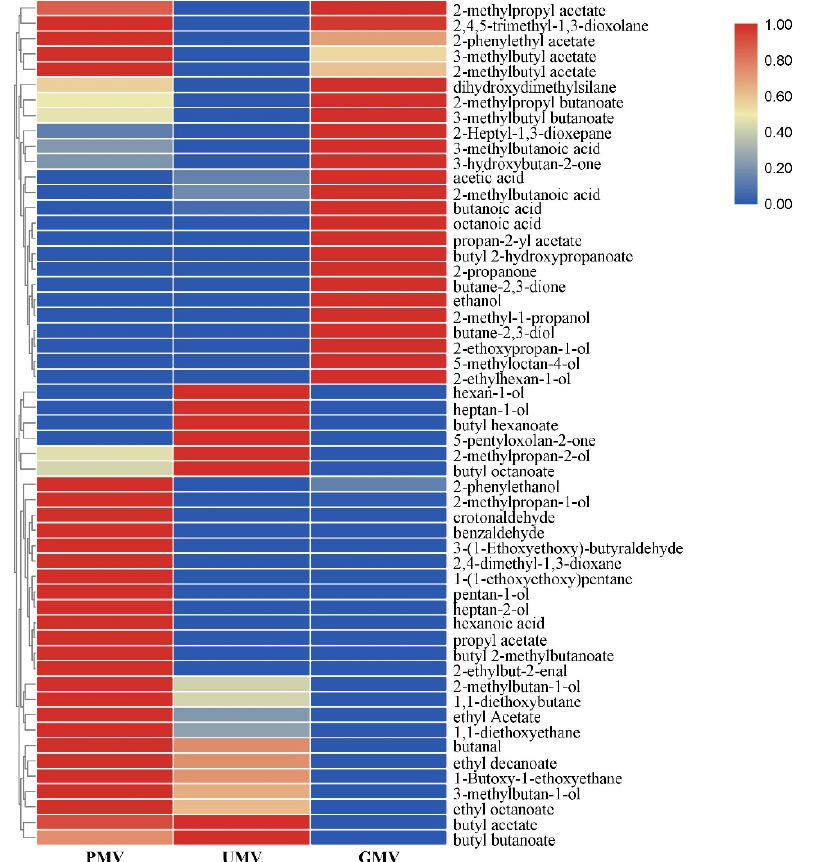
Figure 5. Heatmap of volatile compounds in three obtained MVs. Abbreviations: PMV- Monascus vinegar using polished rice as raw material, UMV- Monascus vinegar using unhusked rice as raw material, GMV- Monascus vinegar using germinated rice as raw material.